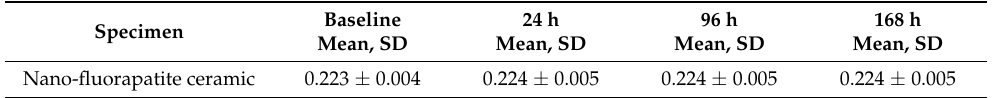
Table 1. Profilometer readings distribution for nano-fluorapatite ceramic immersed in distilled water at baseline and for 24 h, 96 h, and 168 h.